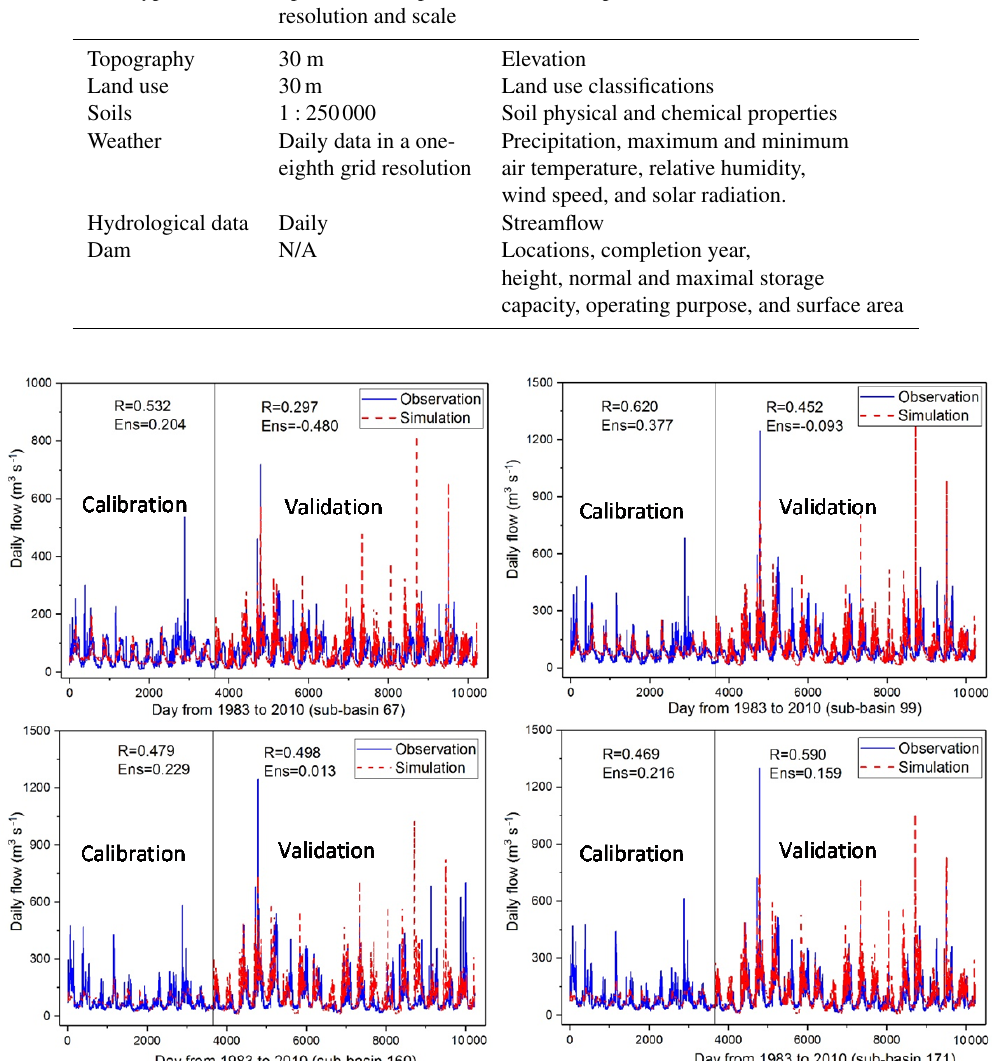
Figure 2. Calibration and validation results in four sub-basins under the R0 scenario (baseline simulation does not consider management